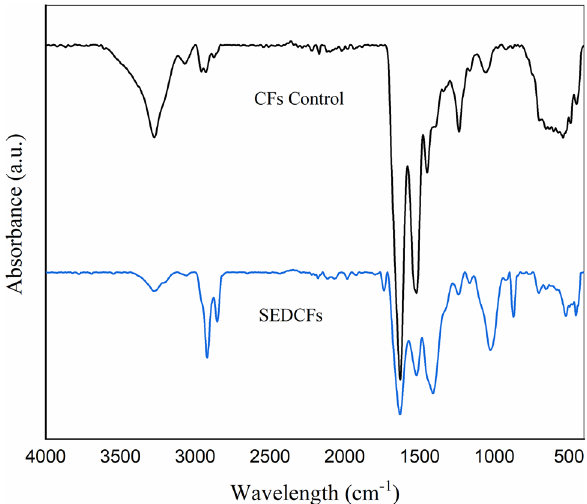
Figure 7. FT-IR spectra of CFs control (black) and SEDCFs